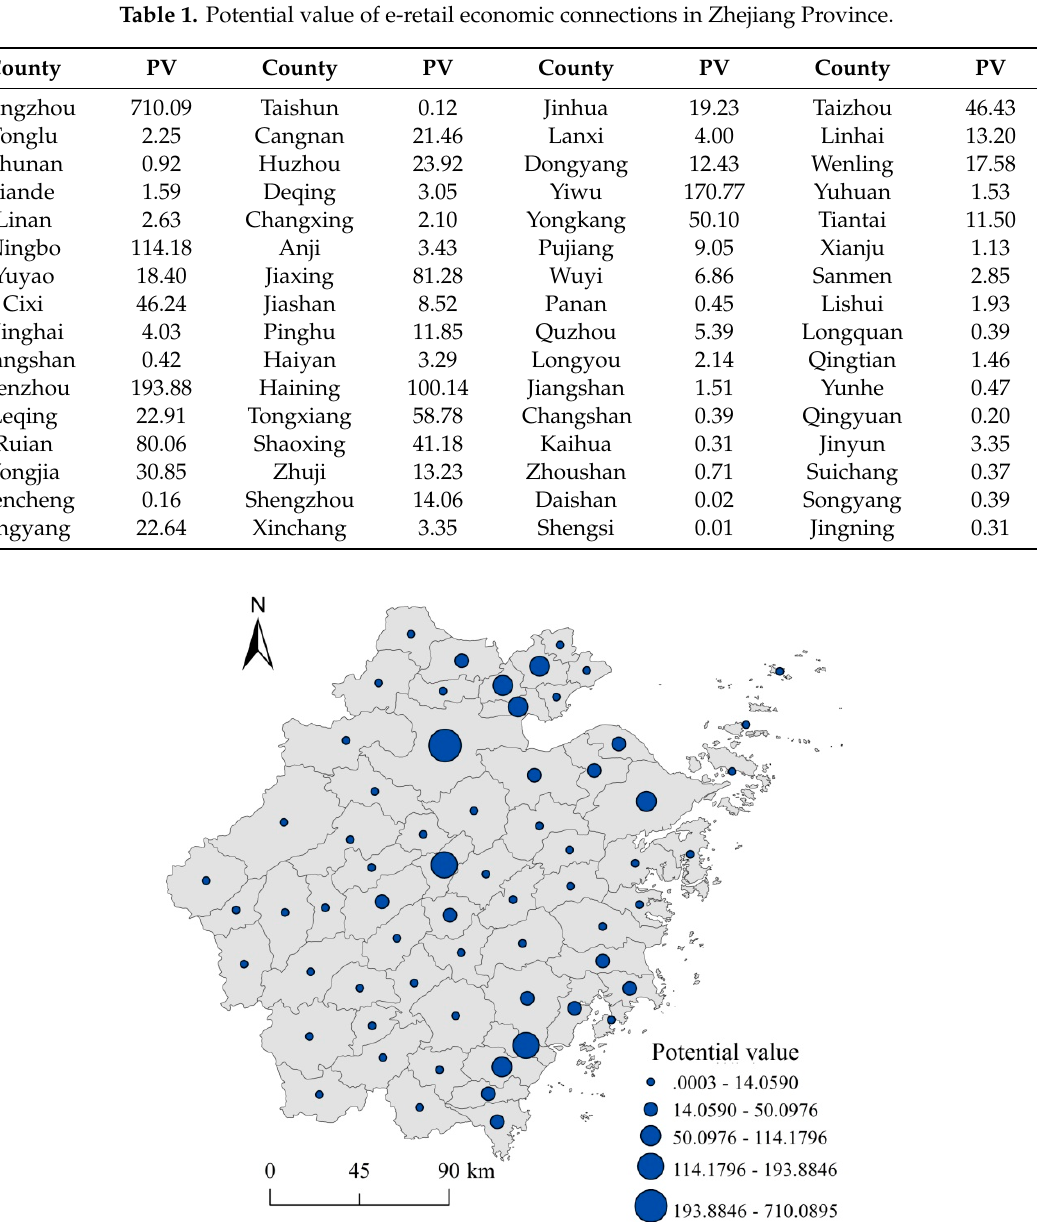
Table 1. Potential value of e-retail economic connections in Zhejiang Province.